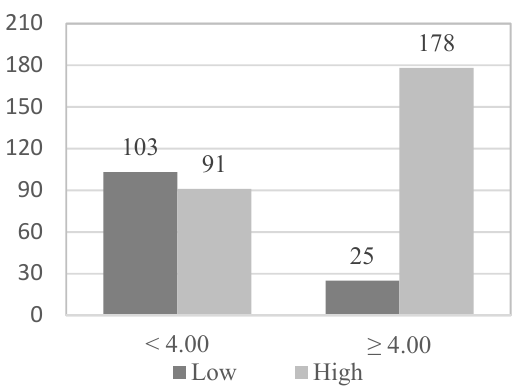
Figure 3. Functional skills_Health satisfaction.